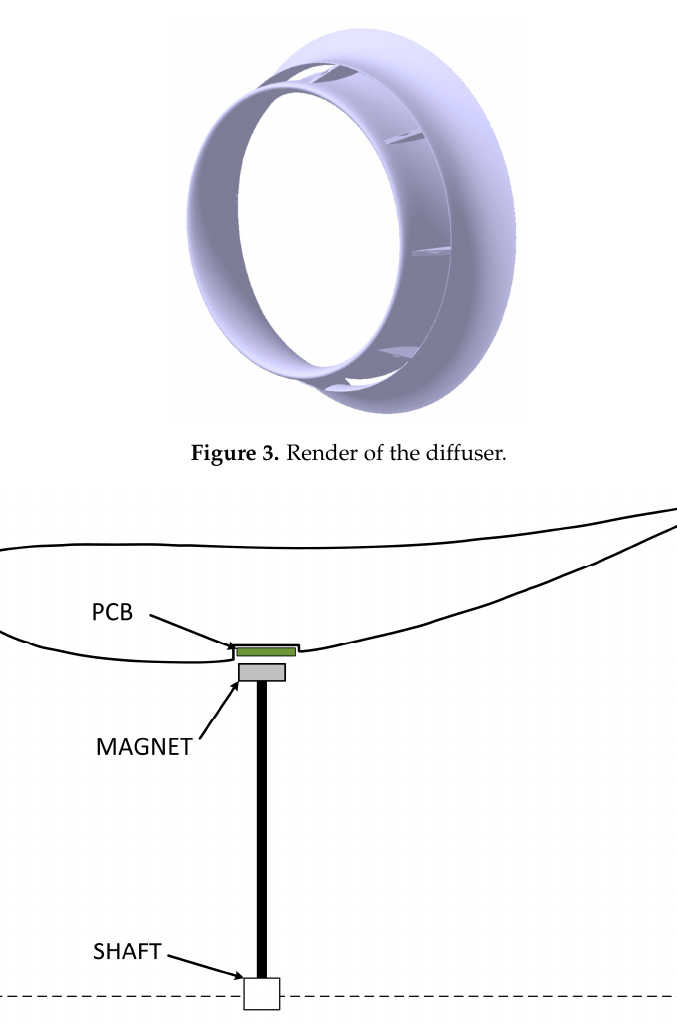
Figure 4. Concept of the annular PM machine with the Printed Circuit Boards (PCB) integrated in the diffuser of the ducted turbine.